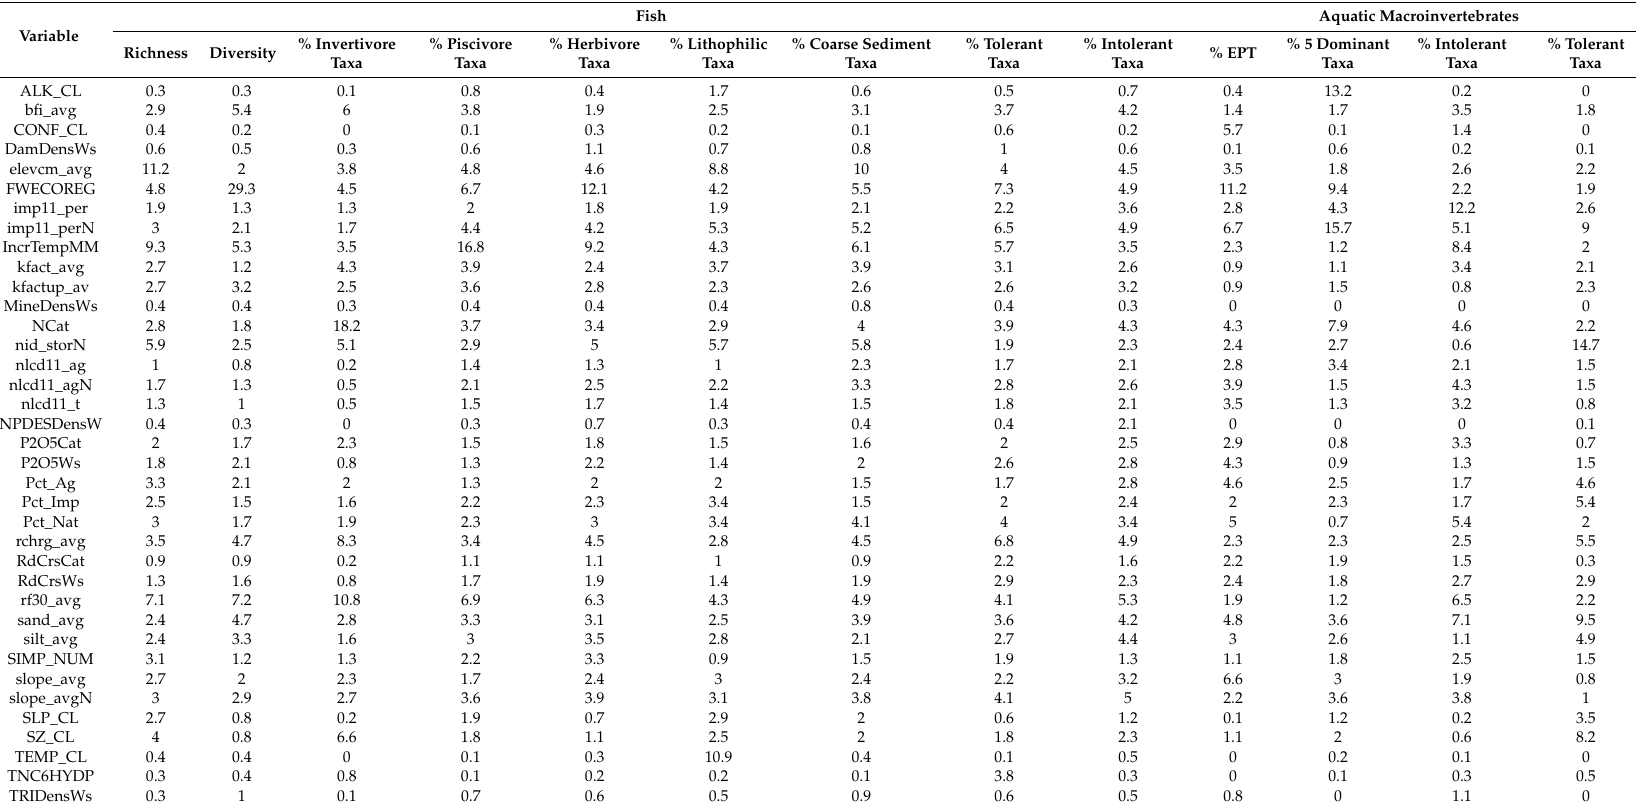
Table 4. Summary of the relative influence of each predictor variable on the response variables for both fish and aquatic macroinvertebrates.